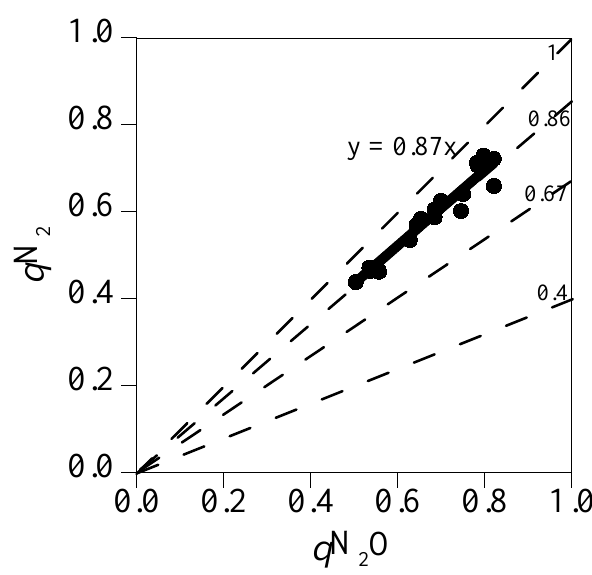
Fig. 5. The plot of q N 2 vs. q N 2 O from concentration series incu- bations. Dashed lines represent the theoretical slope of 1, 0.86, 0.67 Figure 5. The plot of q N 2 vs. q N 2 O from concentration series incubations. Dashed 925 and 0.40, which corresponding to ra of 0, 25, 50 and 75%, respec- tively. The slope of regression is 0.87 ± 0.03 ( r 2 = 0 . 95, p < 0 . 05, lines represent the theoretical slope of 1, 0.86, 0.67 and 0.40, which corresponding to 926 n = 21) corresponding to ra of 23 ± 4%. ra of 0%, 25%, 50% and 75%, respectively. The slope of regression is 0.87 ± 0.03 (r 2 927 = 0.95, p < 0.05, n = 21) corresponding to ra of 23 ± 4%. 928